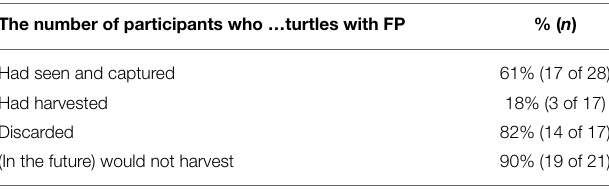
TABLE 1 | Results from interviews about fibropapillomatosis (FP). The number of participants who …turtles with